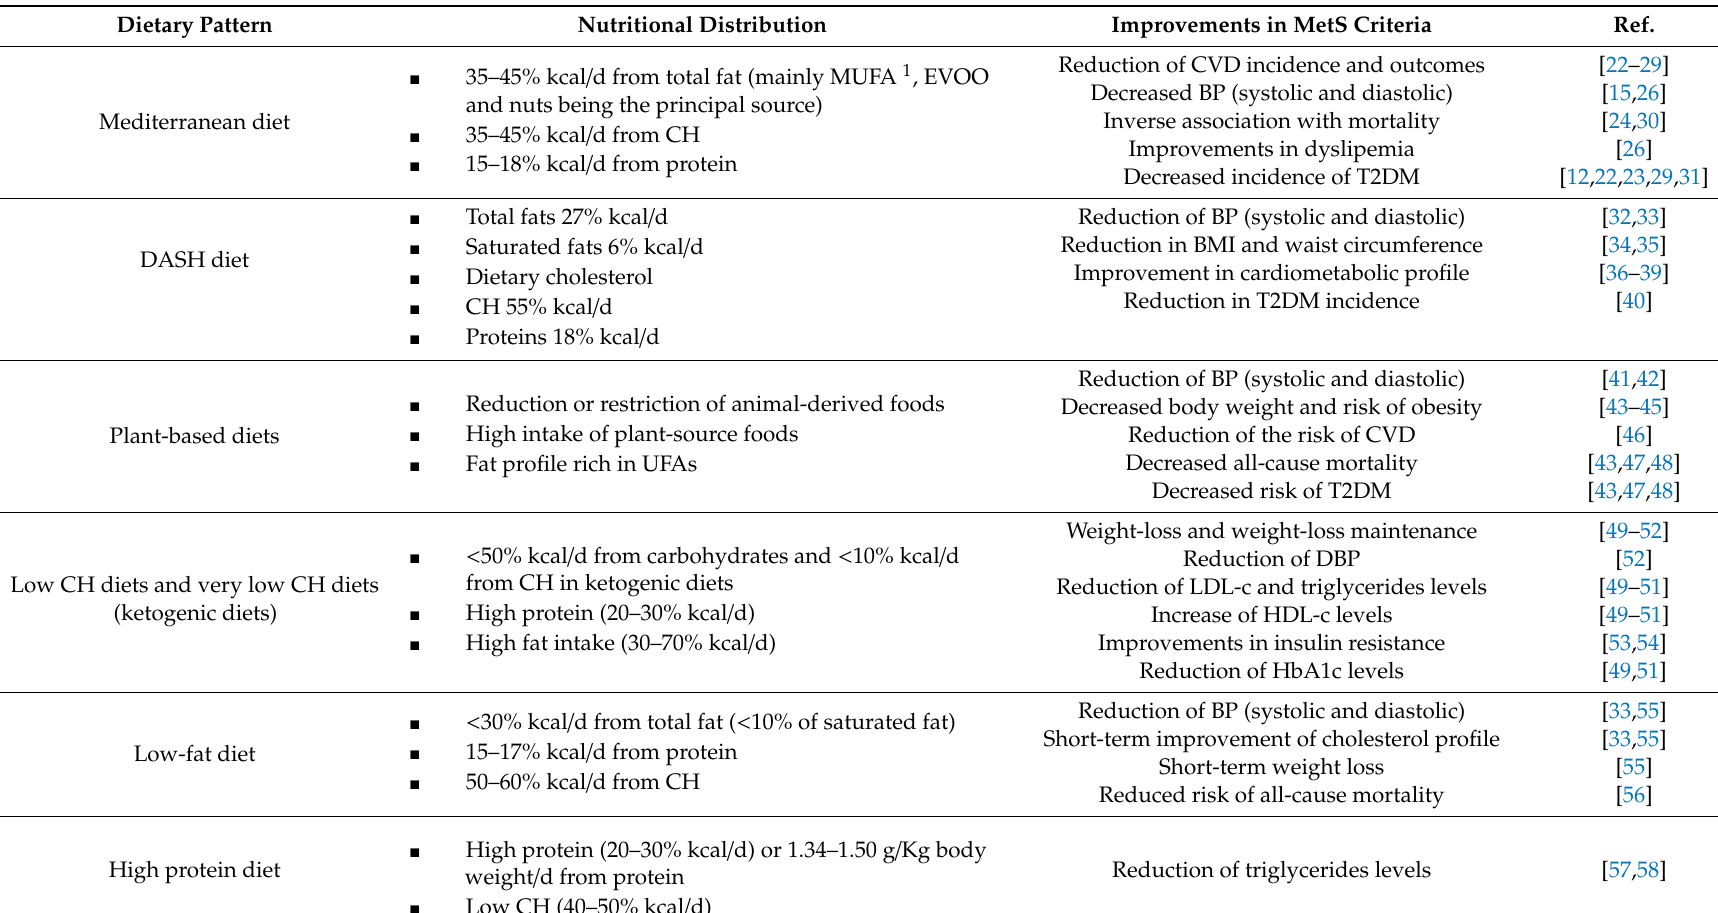
Table 1. Dietary strategies and potential health benefits for Metabolic Syndrome